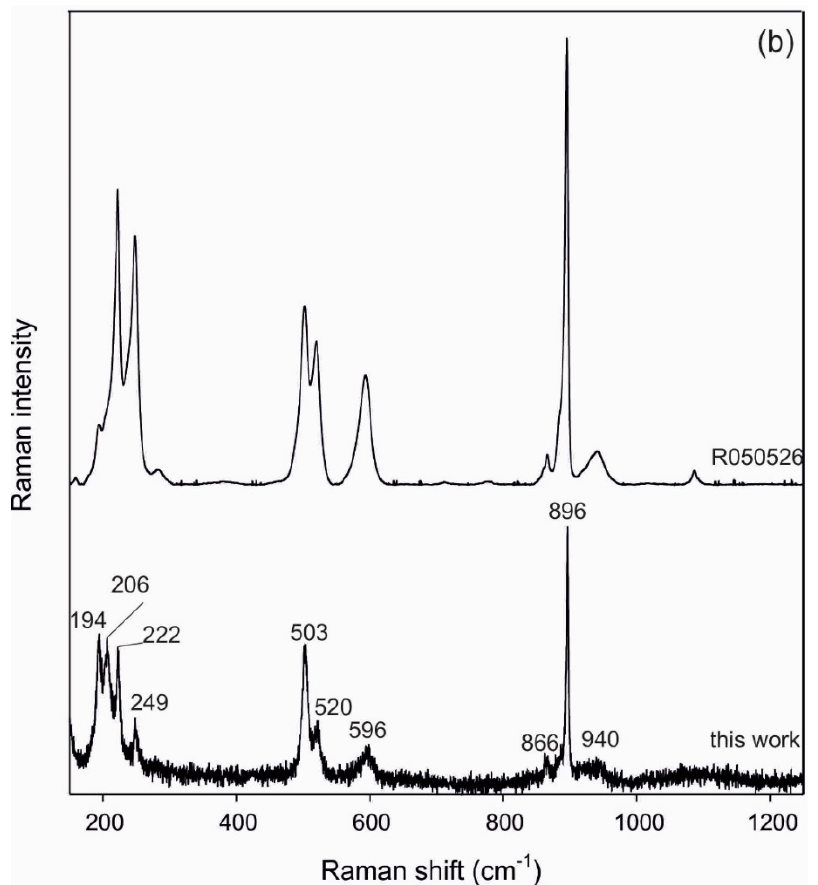
Figure 8. Raman spectrum of whewellite ( a ) in the C-C stretching region and ( b ) the range from 100 to 1300 cm -1 (the comparison to spectrum of whewellite sample R050526 from RRUFF database (rruff.org) is also provided).